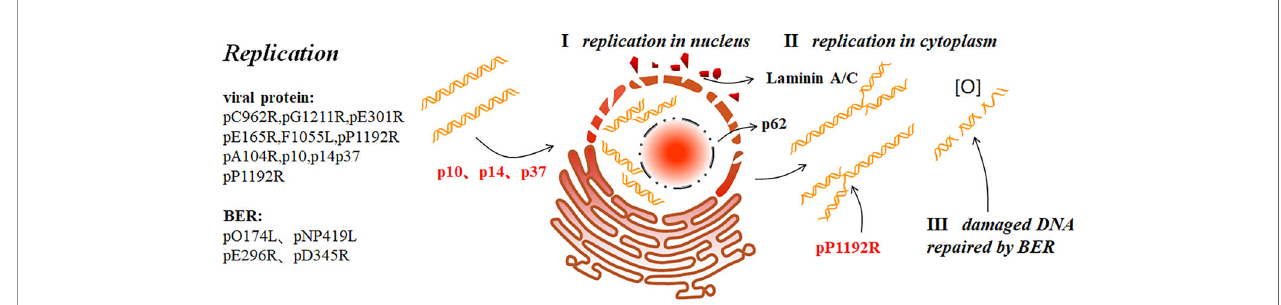
FIGURE 3 | ASFV replication (9). ASFV fi rst replicates brie fl y in the nucleus (I), and then the cytoplasm (II). p37 mediates the nucleocytoplasmic transport of ASFV genome. In addition, p10 and p14 can also enter the nucleus. ASFV replication in the nucleus ruptures the nucleolus and nuclear membrane, thus collapsing laminin A/C and recruiting the nucleoporin p62 to the periphery. ASFV produces short DNA fragments the nucleus and long fragments in the cytoplasm. pP1192R catalyzes transient nick generation in double-stranded DNA and promotes the translation process. To prevent active oxygen-mediated damaged DNA from interfering with replication, ASFV also uses BER to repair the damaged